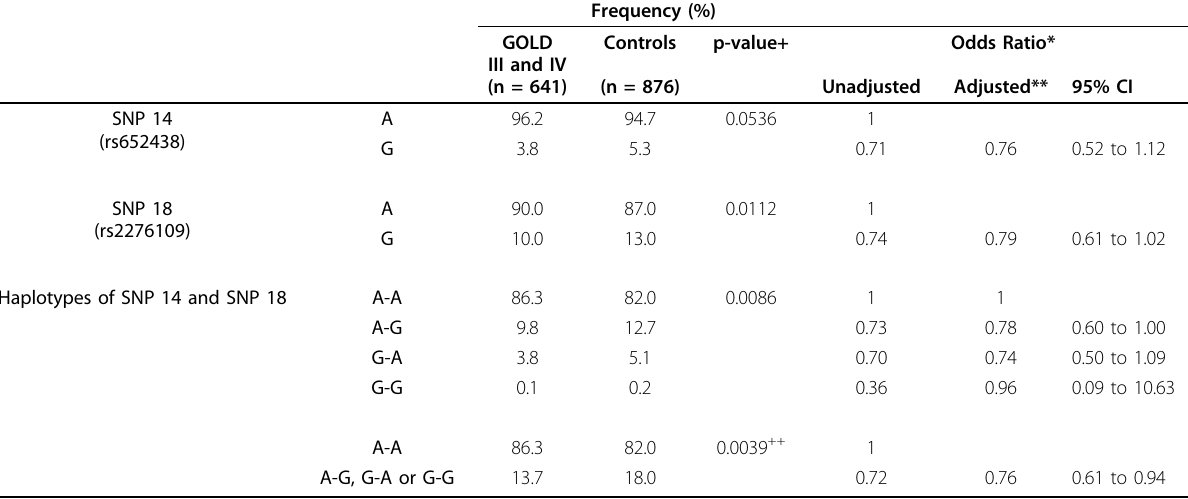
Table 8 MMP - 12 haplotypes significantly different between GOLD Classification III and IV cases and